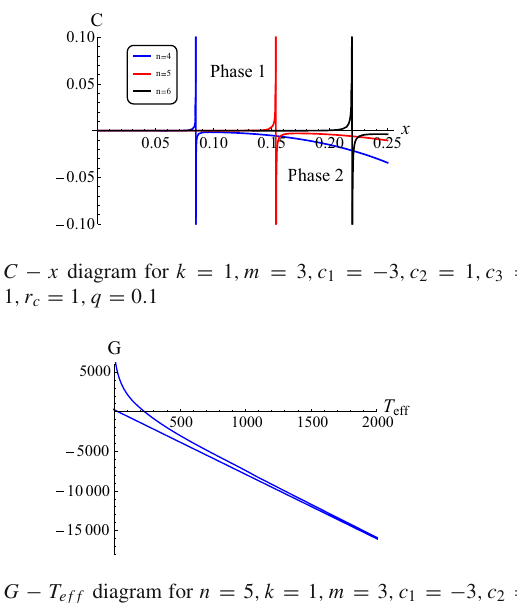
Fig. 3 T ef f − x diagrams when the parameters change respectively